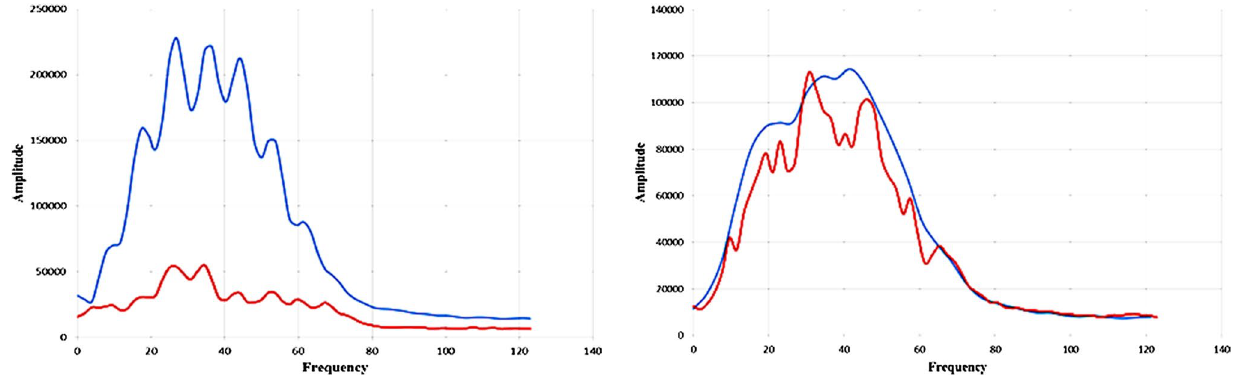
Fig. 12 Frequency spectra and their responses in gas case (left) and without gas